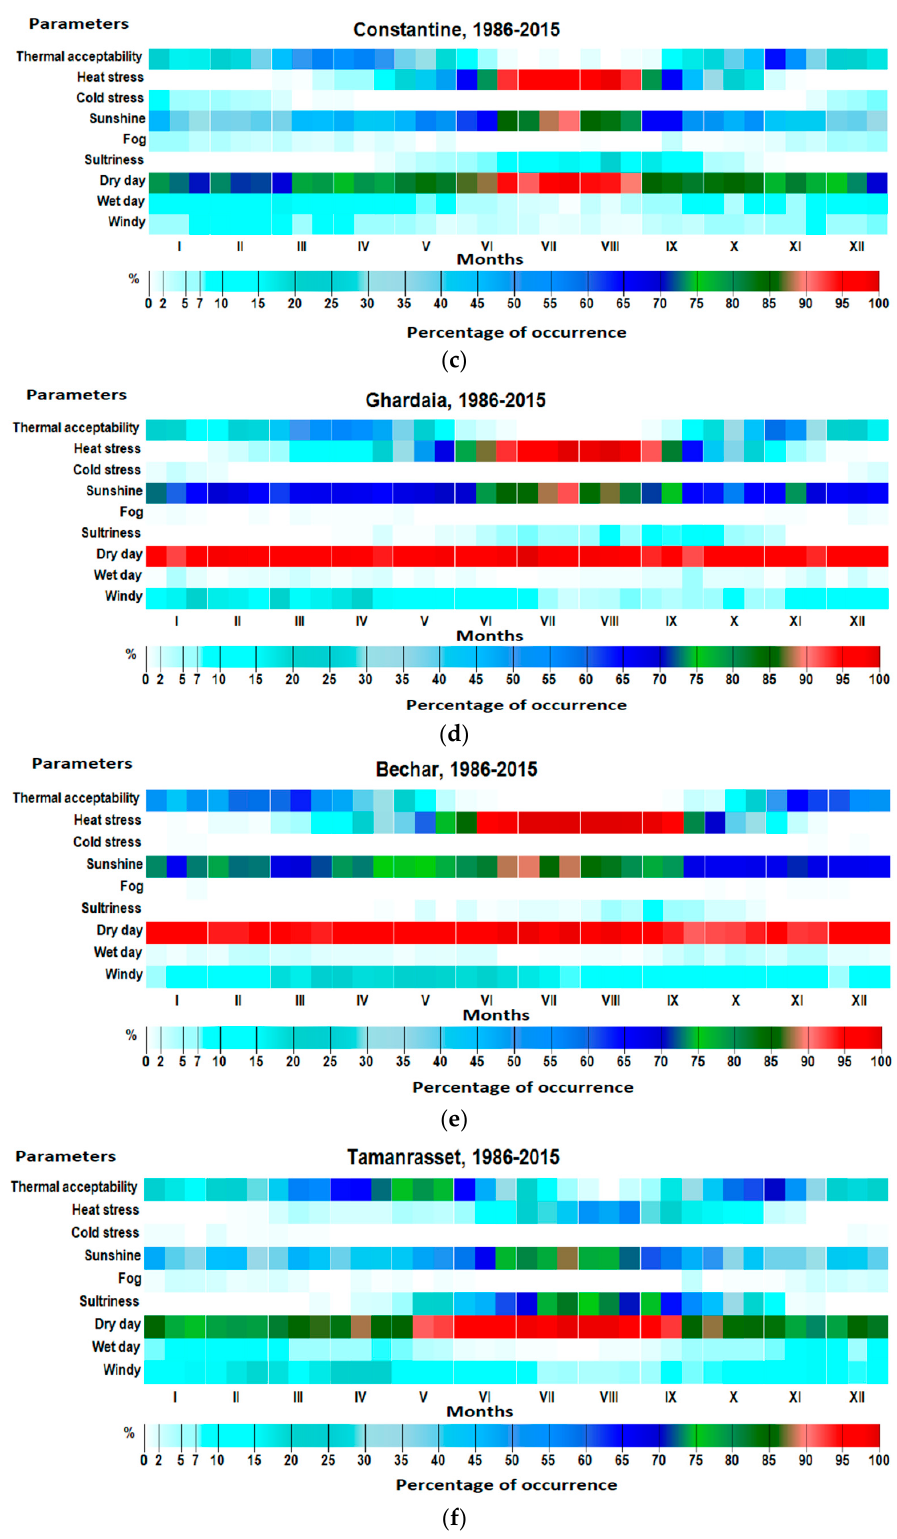
Figure 3. Climate-Tourism-Information-Scheme between 1986 and 2015: ( a ) for Algiers; ( b ) for Oran; ( c ) for Constantine; ( d ) for Ghardaia; ( e ) for Bechar and ( f ) for Tamanrasset.